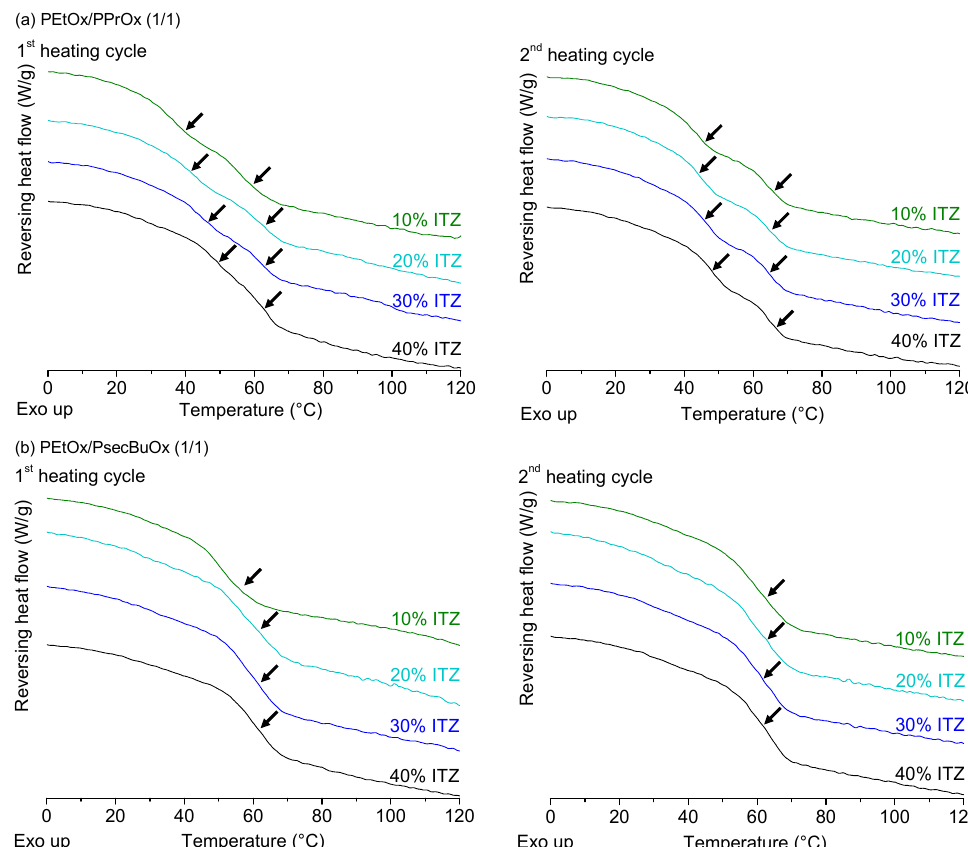
Figure 10. mDSC thermograms of ITZ, spray dried with a polymer blend of PEtOx/PPrOx (1/1) ( a ) and of PEtOx/PsecBuOx (1/1) ( b ). ASDs with four different drug loadings were prepared. Glass transitions are indicated with arrows in both first (left) and second heating cycle (right). Average T g values ( n = 3) can be found in Supplementary Information S5b. Created with Origin 8.5 from OriginLab (Northampton, MA, USA).